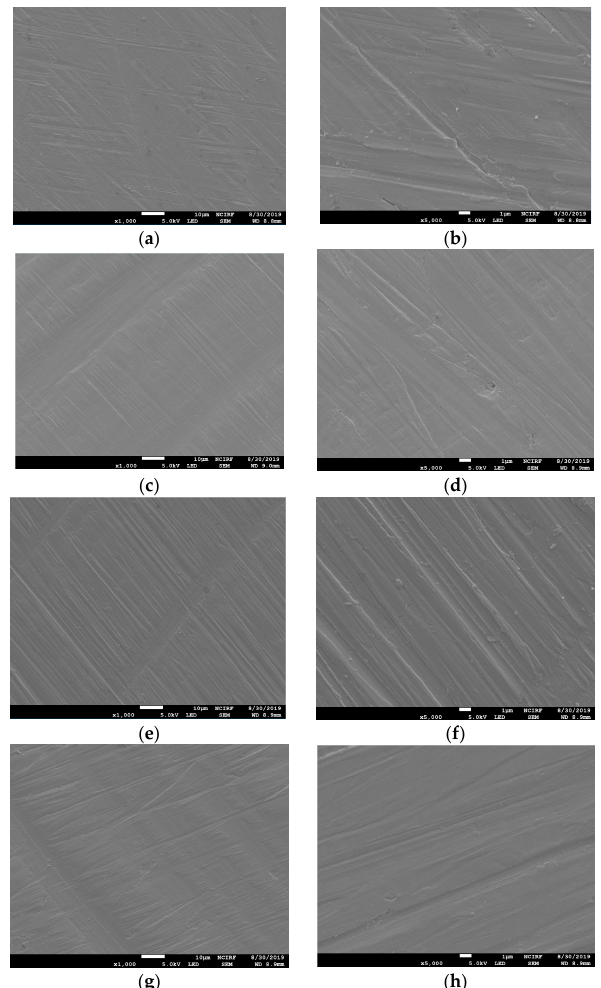
Figure 1. Scanning electron microscope (SEM) images of the surfaces of non-polished Ni-Cr and Co- Cr disks. Ni-Cr group: each row, left to right, original magnification ( a ) 1000×, ( b ) 5000×. Co-Cr (casting) group: ( c ) 1000×, ( d ) 5000×. Co-Cr (milling) group: ( e ) 1000×, ( f ) 5000×. Co-Cr (3D) group: ( g ) 1000×, ( h ) 5000×.